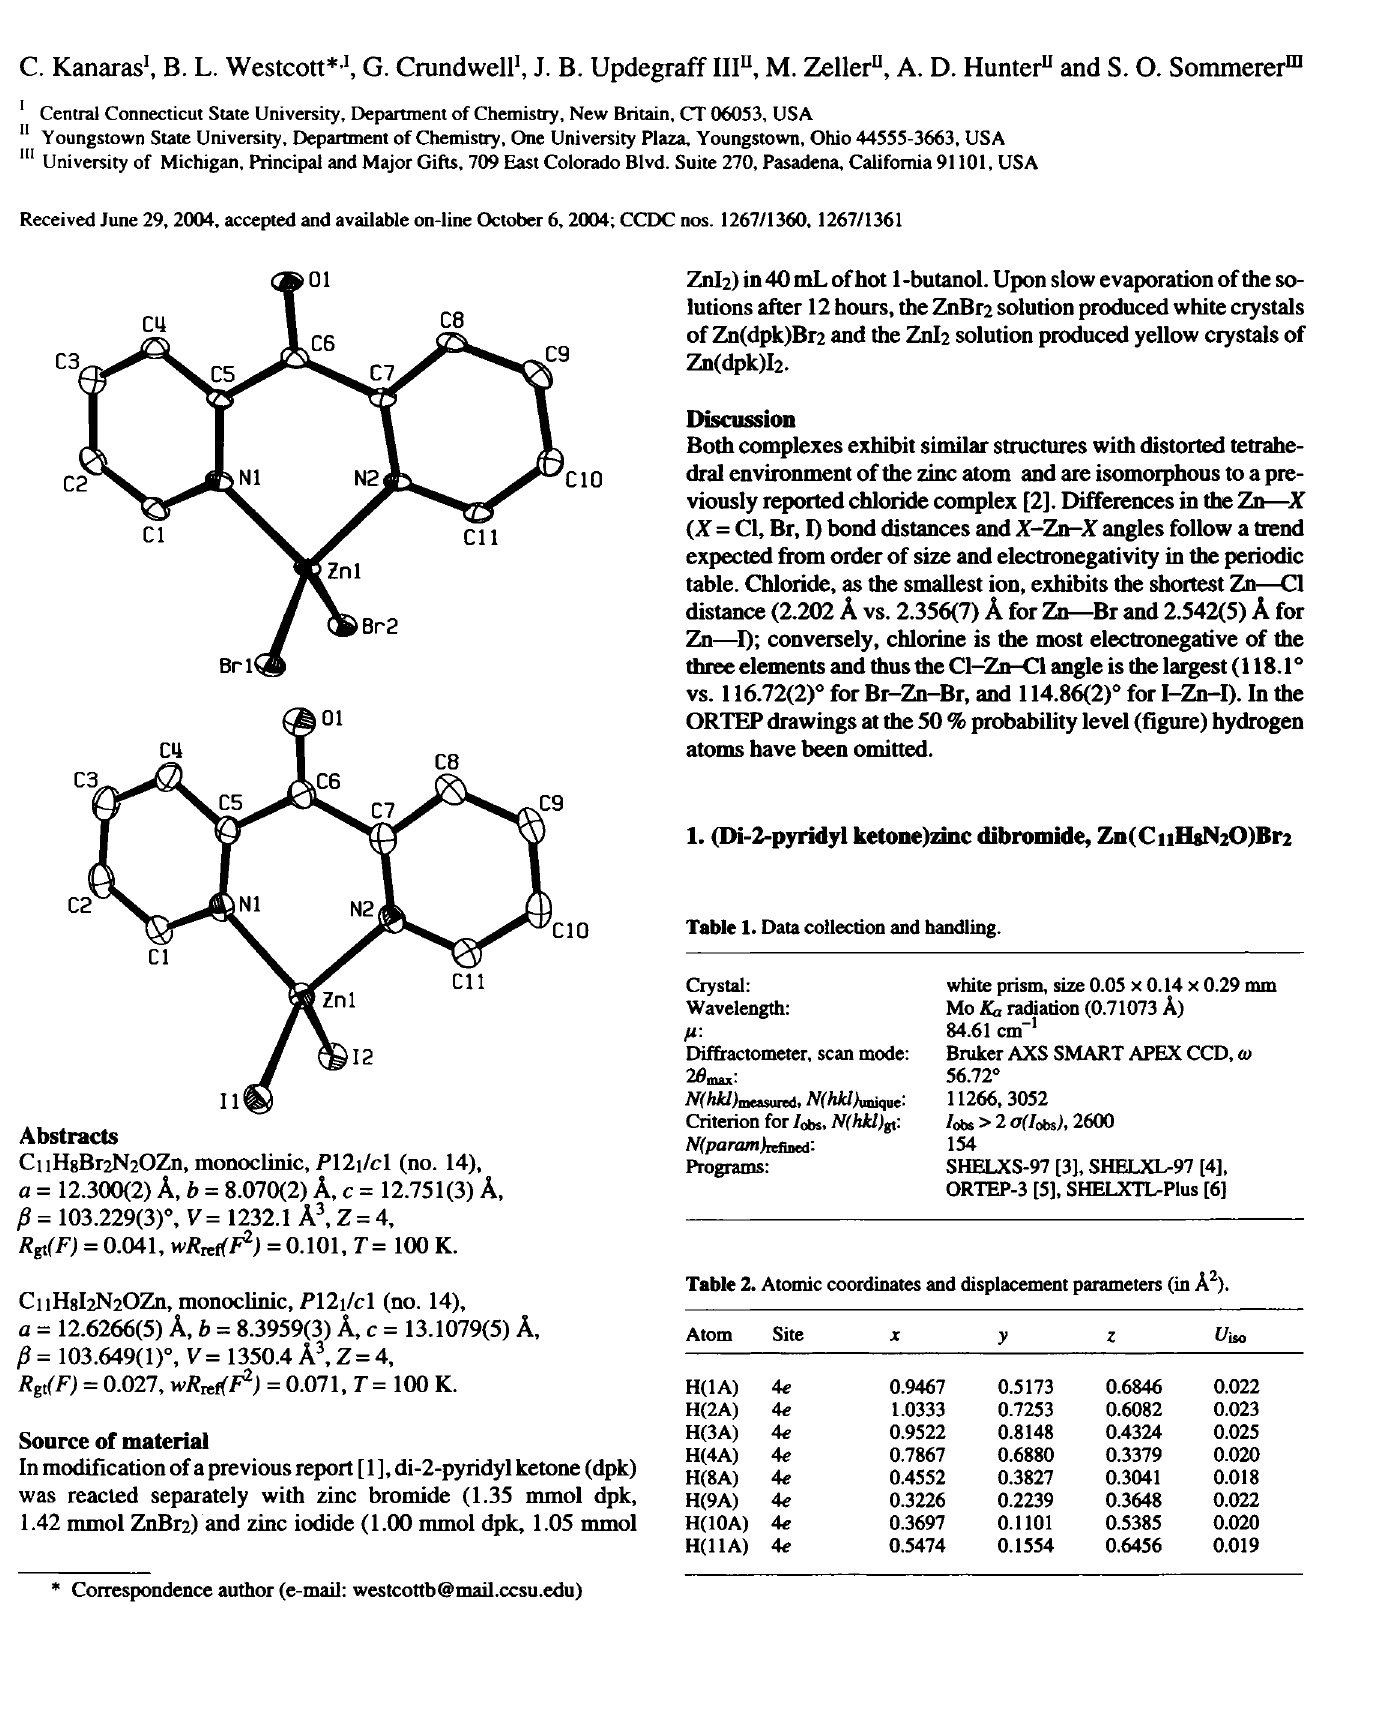
Table 2. Atomic coordinates and displacement parameters (in Â 2